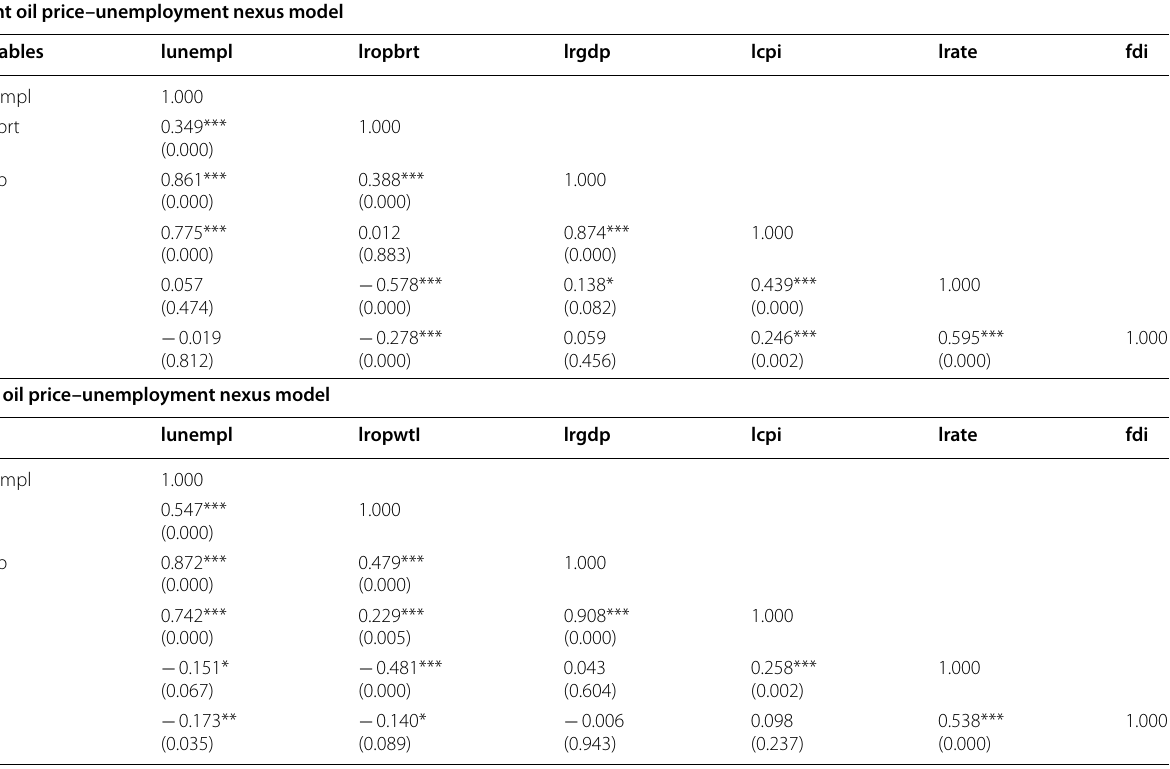
Table 7 Correlation analysis results. Source: Computed by the